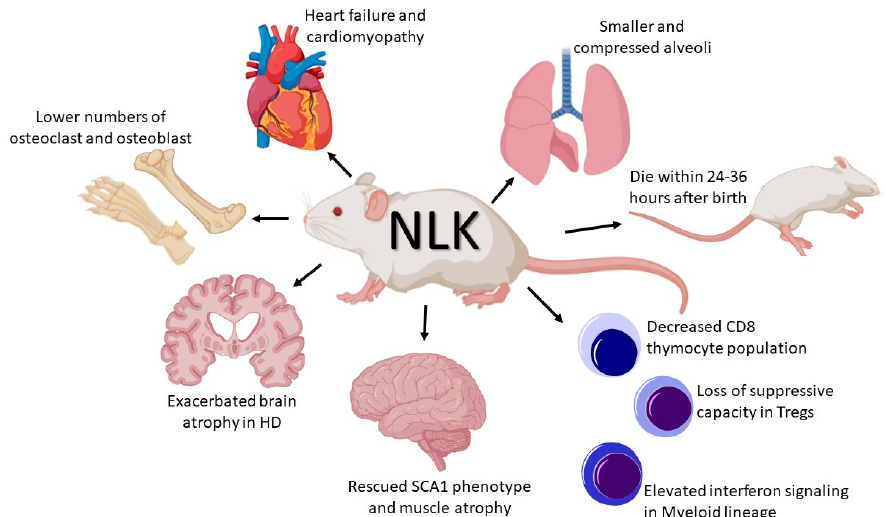
Figure 1. Discoveries in the field of NLK signalling using mouse models. NLK is an evolutionary conserved MAP kinase known to be a negative regulator of the Wnt / β -catenin signalling pathway. Over recent years, mouse models targeting NLK have been established that have led to the discovery of NLK playing an important role in the function of organs including heart, lung, and skeleton. and di ff erentiation of various immune cells. Finally, evidence has shown that NLK can regulate the phenotype seen in numerous neurodegenerative diseases. Representative summaries are given of major findings regarding the use of mouse models to study the function of NLK signalling. Images in the figure is taken from